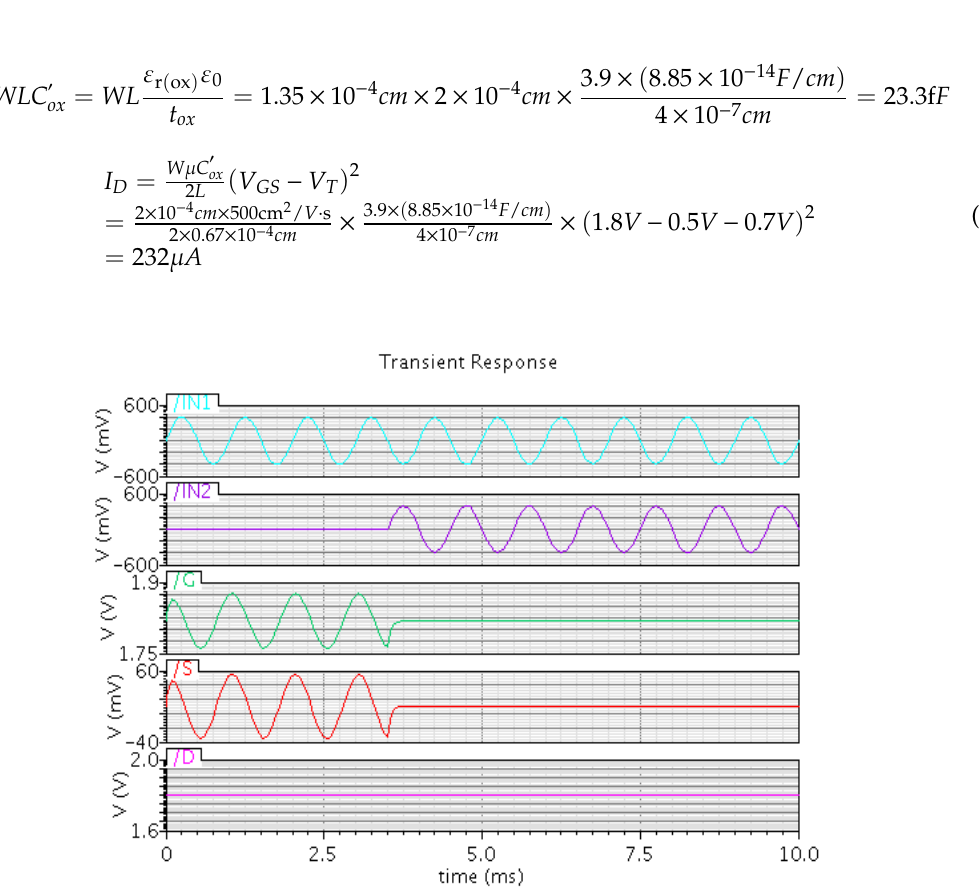
Figure 6. Simulation result of the proposed ANC device, where signals IN 1 , IN 2 , G, S, and D are the measured voltages from the red node IN 1 , IN 2 , G, S, and D shown in Figure 5, and signals IN 1 and IN 2 are simulated as the primary interference and secondary interference, respectively. From 0 to 3.5 ms, only signal IN 1 modulates the gate voltage with a certain attenuation and the source voltage follows the gate voltage. After 3.5 ms, signals IN 1 and IN 2 both modulate the gate voltage and the source voltage becomes a DC voltage without noise.